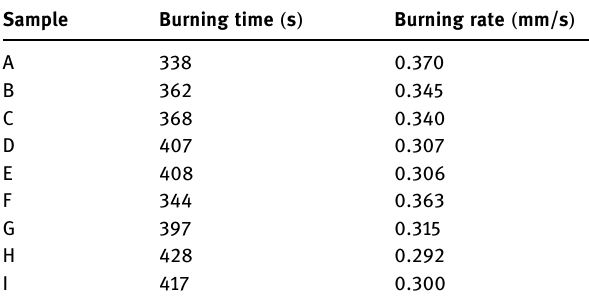
Table 2: L9 Horizontal burning test results for FF/VE composites used in the face sheets